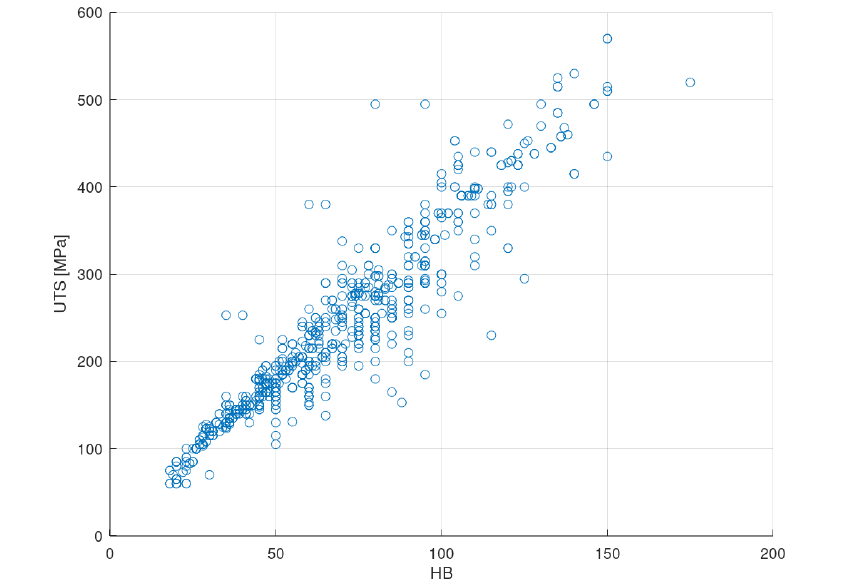
Figure 9. Ultimate tensile strength-Brinell hardness scatter plot of the input dataset.